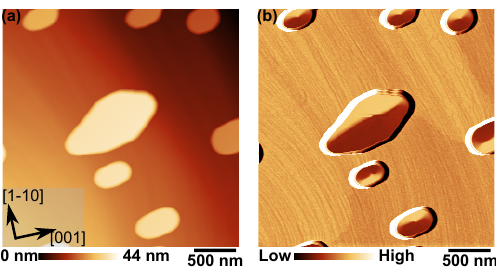
Figure 2. ( a ) STM topography of Fe islands on W(110) recorded at 4.2 K; ( b ) Simultaneously recorded spin-polarized dI / dU map showing magnetic contrast in the islands in the form of magnetic vortices ( I t = 1 nA, U 0 = − 400 mV, U mod = 50